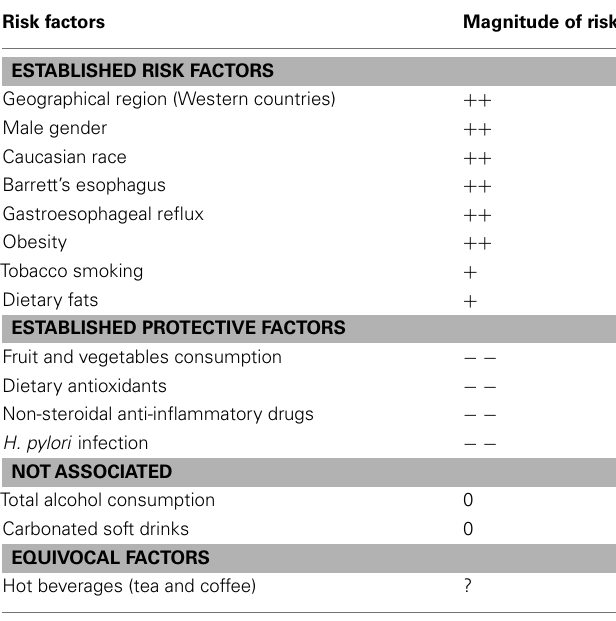
Table 1 | Summary of risk factors for esophageal